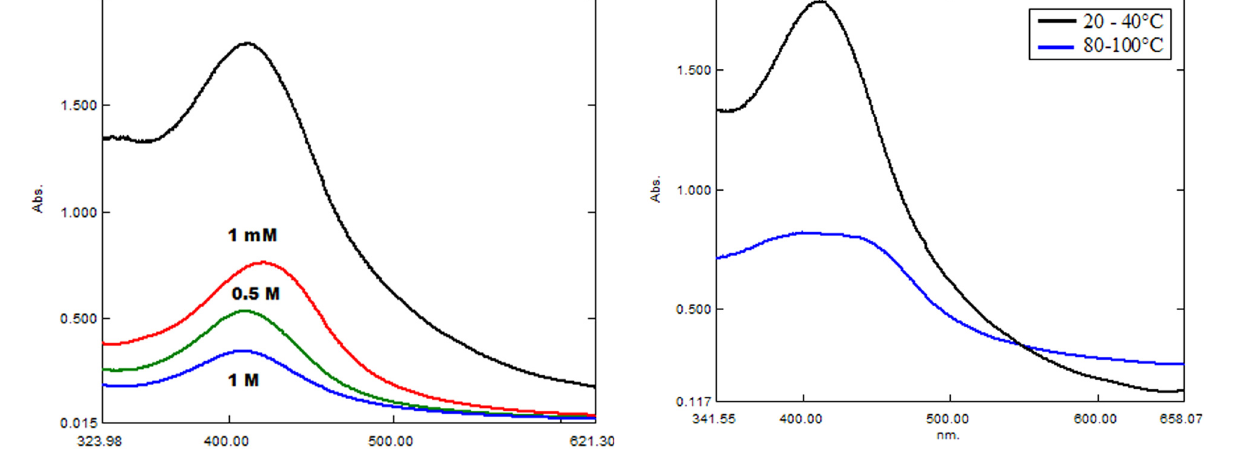
Figure 3: Comparison of UV - Vis spectra of AgNPs stability at di ff erent NaCl salt concentrations.